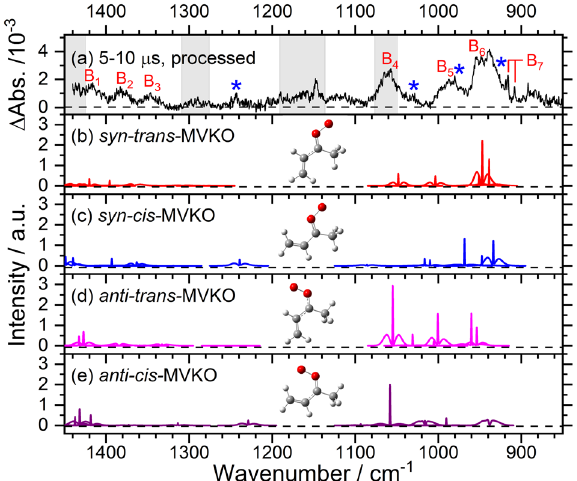
Fig. 3 Comparison of bands in group B with simulated spectra of various conformers of Criegee intermediate MVKO. a Spectrum (resolution 0.5 cm − 1 ) of bands in group B recorded 5 – 10 μ s after photolysis; taken from Supplementary Fig. 8(g); bands are labeled B 1 ‒ B 7 . Gray areas represent regions of possible interference from absorption of the parent molecule. IR spectra simulated with PGOPHER ( J max = 200, T = 298 K, FWHM = 0.64 cm − 1 ) are shown for b syn-trans- MVKO (3) , c syn-cis- MVKO, d anti- trans- MVKO, and e anti-cis- MVKO. Possible bands of syn-cis- MVKO are marked with blue